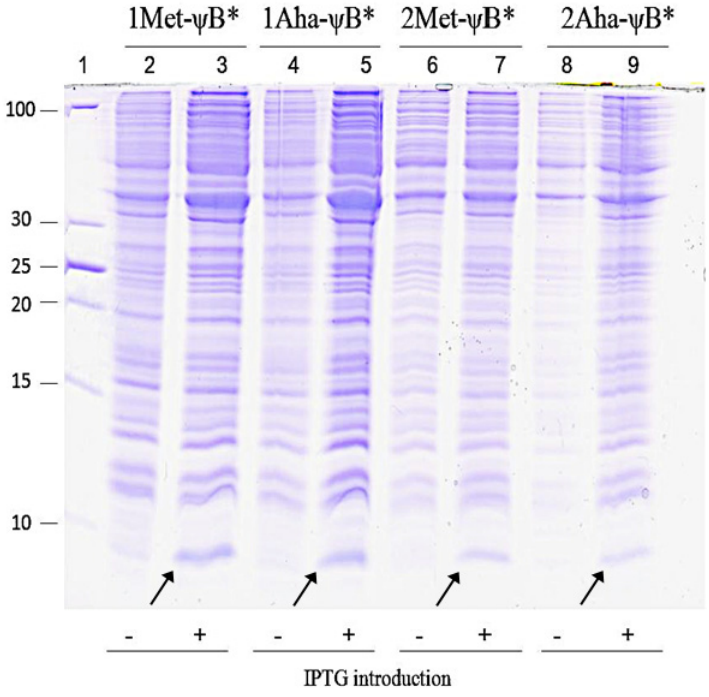
4. Coomassie-stained 20% SDS-PAGE showing Met- ψ B* and Aha- ψ B* expression. Aha- ψ B* refers to ψ B* expressed in presence of Oahs and NaN ψ B* refers to the positive control, in which Met was added to the system. Lane 1: